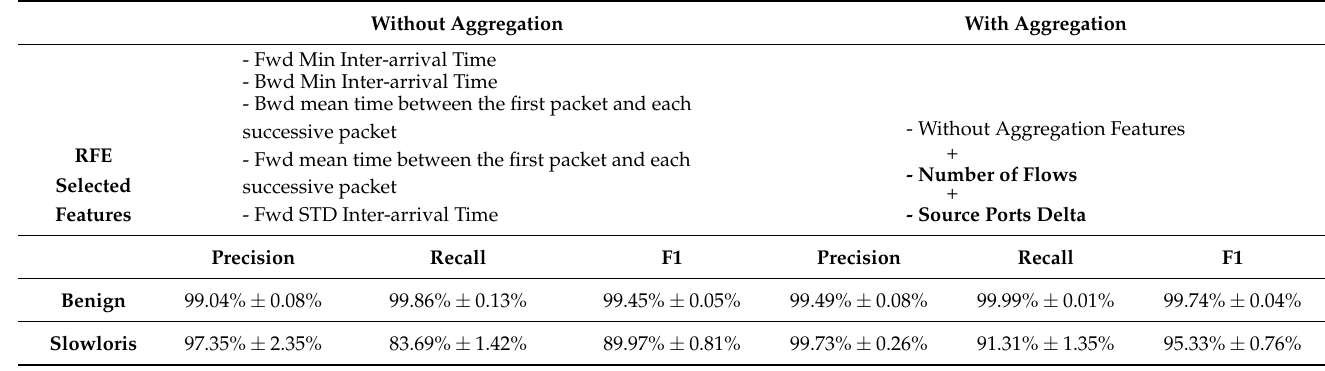
Table 4. Benign vs. Slowloris classification (5-fold cross validation).